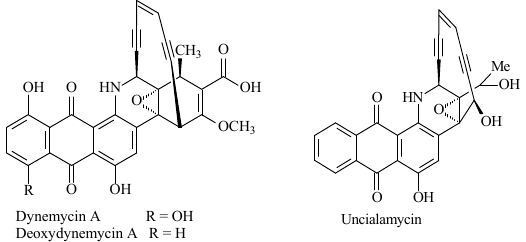
Figure 1. The structure of enediyne antibiotics.